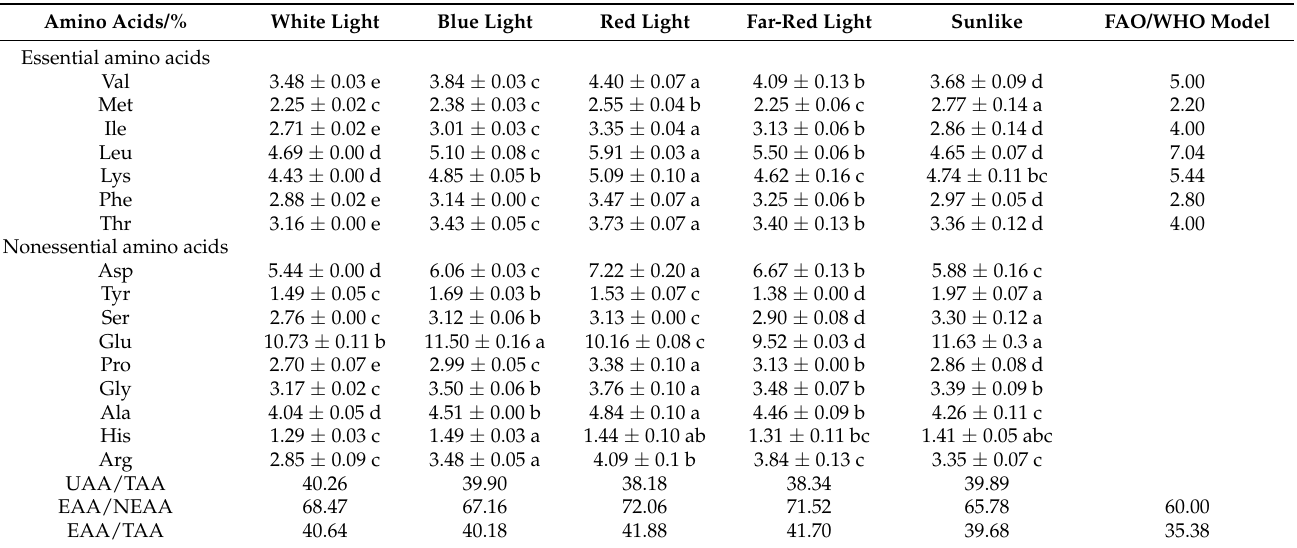
Table 6. Comparison of amino acid composition and content in proteins of P. eryngii fruiting bodies under different light quality